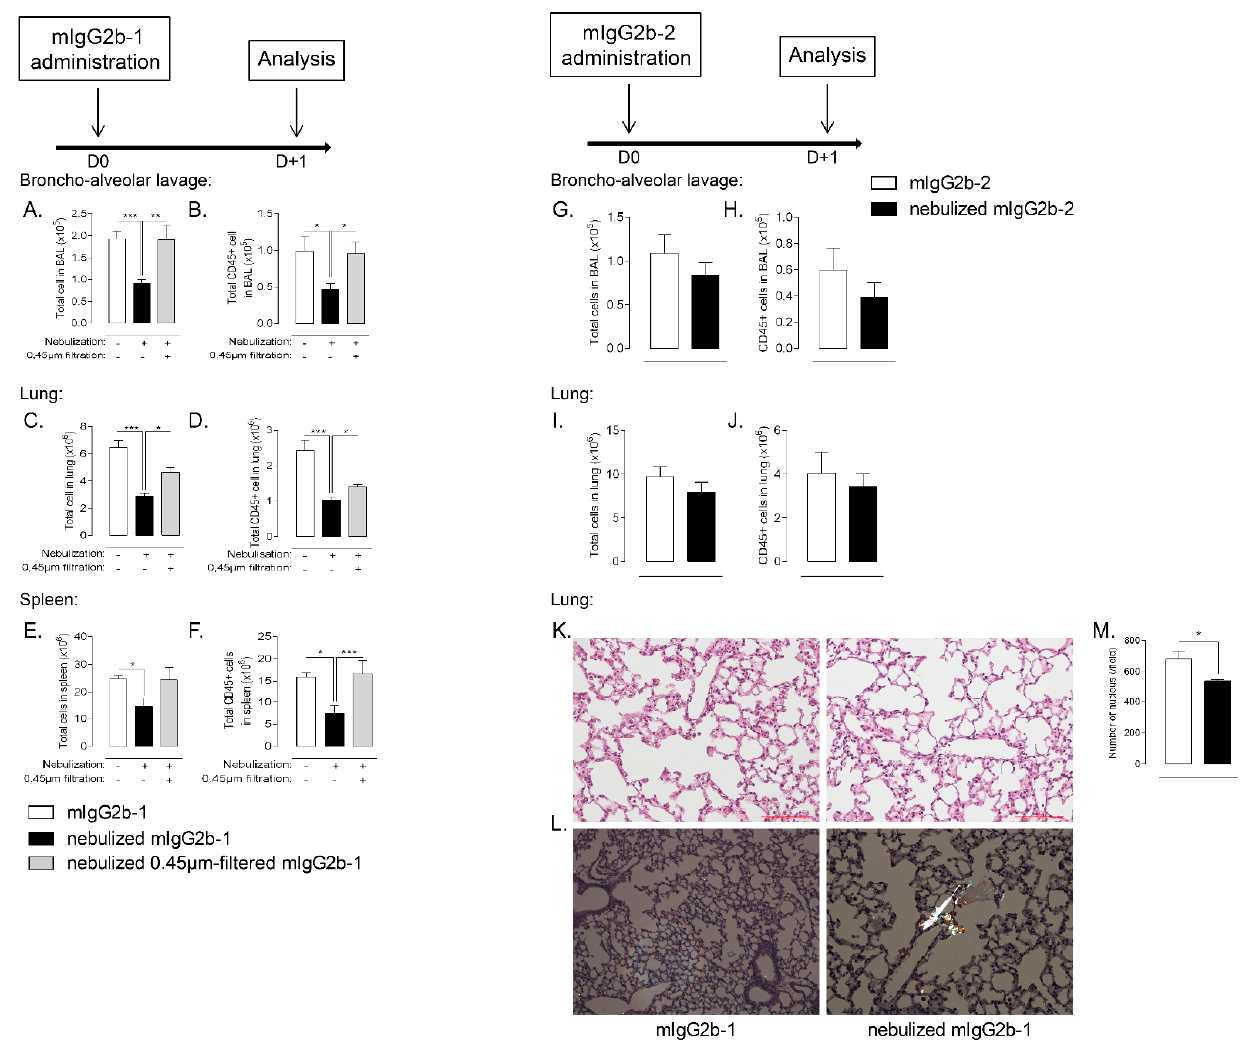
Figure 3. B6 mice received a 40 µL orotracheal instillation of mIgG2b-1 at 100 µg/mL either native (white bars), nebulized (black bars) or nebulized and 0.45 µm-filtered (gray bars). The total number of cells ( A , C , E ) and CD45+ cells ( B , D , F ) were quantified in BAL ( A , B ), in the lungs ( C , D ) and the spleen ( E , F ) using flow cytometry, 18 h after the administration. B6 mice received a 40 µL orotracheal instillation of mIgG2b-2 at 100 µg/mL either native (white bars) or nebulized (black bars). The total number of cells ( G , I ) and CD45+ cells (H and J) were quantified in BAL ( G , H ), in the lungs ( I , J ) using flow cytometry, 18 h after the administration. Lung tissues of mice treated with either native (white bars) or nebulized (black bars) mIgG2b-1 were histologically examined 18 h after the administration. ( K ) Hematoxylin-eosin sections were used to quantify cell nucleus ( M ) by machine-learning (see material and methods section). ( L ) Congo red sections were observed under polarized light. Aggregates are identified as apple-green birefringence artifacts. 10 sections/mouse were observed at x20 magnification and used for machine-learning quantification. The data are quoted as the mean ± SEM. *, **, ***: p < 0.05, p < 0.01 and p < 0.001, respectively, in a one-way ANOVA with